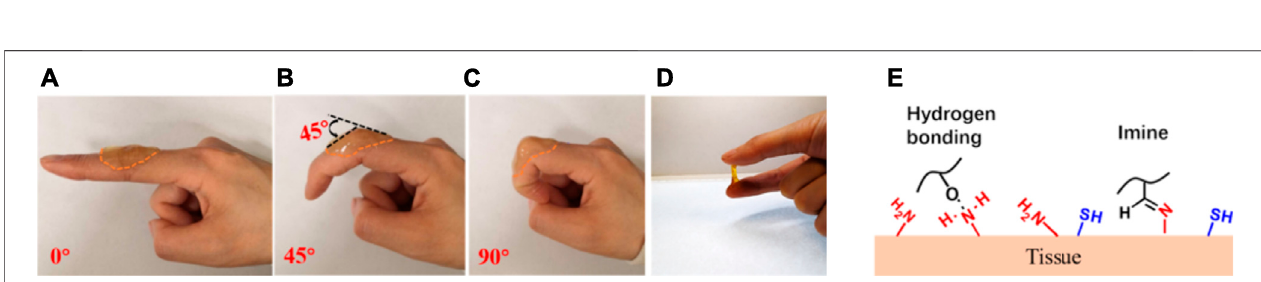
FIGURE5| AdhesionofCHI/ACHI5-5hydrogel. (A) Fingerextendedat0 ° withhydrogelattached, (B) fi nger fl exedto45 ° withhydrogelattached, (C) fi nger fl exedto 90 ° withhydrogelattached, (D) hydrogeladheredtotwo fi ngers, (E) themechanismofadhesionthroughhydrogenbondandSchiffbaseformation(Wangetal.,2020b). CHI, chitosan; ACHI, aldehyde-chitosan. Images were adapted with permission from Wang et al. (2020b). Copyright 2020, American Chemical Society.